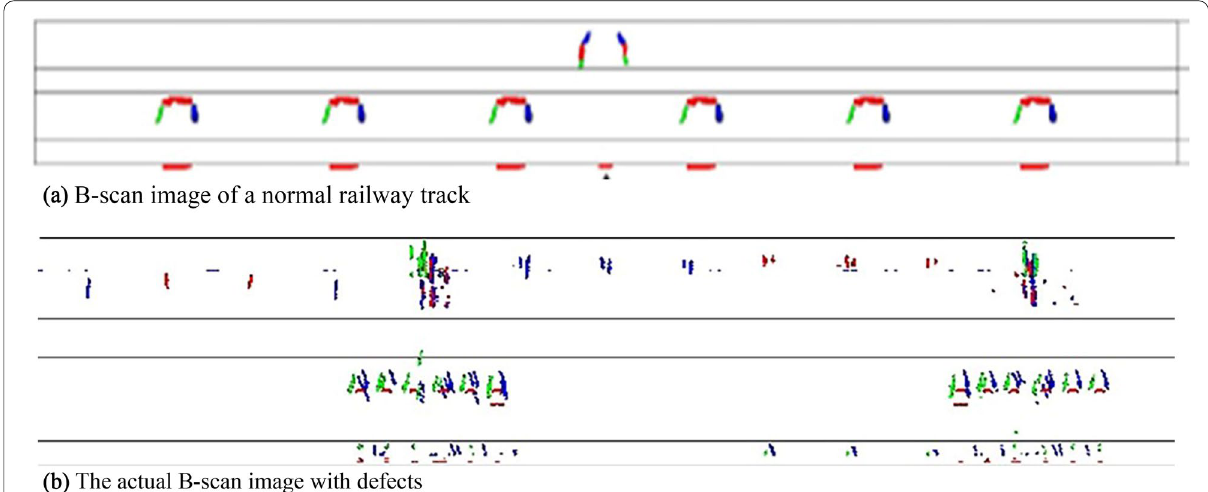
Figure 3 Ultrasonic B-scan images in different situations